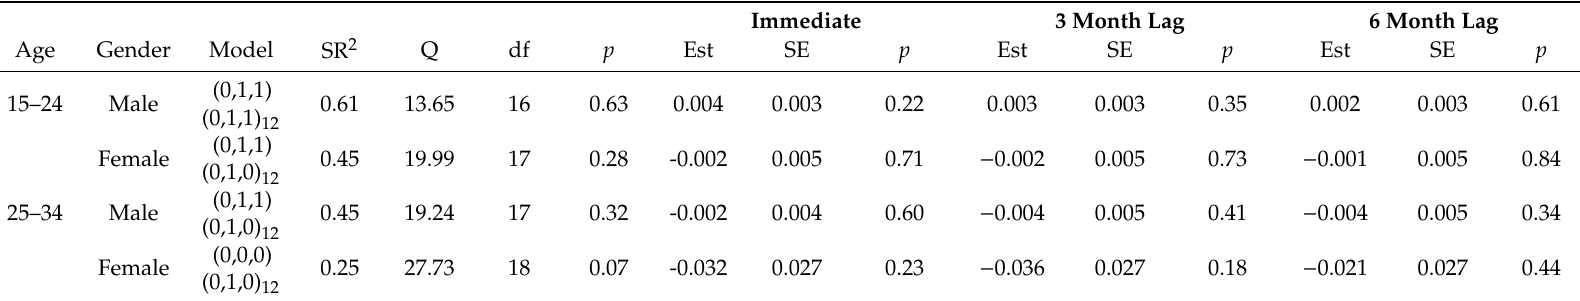
Table 2. Autoregressive integrated moving average (ARIMA) model results of the association between introduction of the alcopops tax and monthly chlamydia notification rates per 100,000 population (primary outcome) by age group and gender, July 2000 to December 2016.